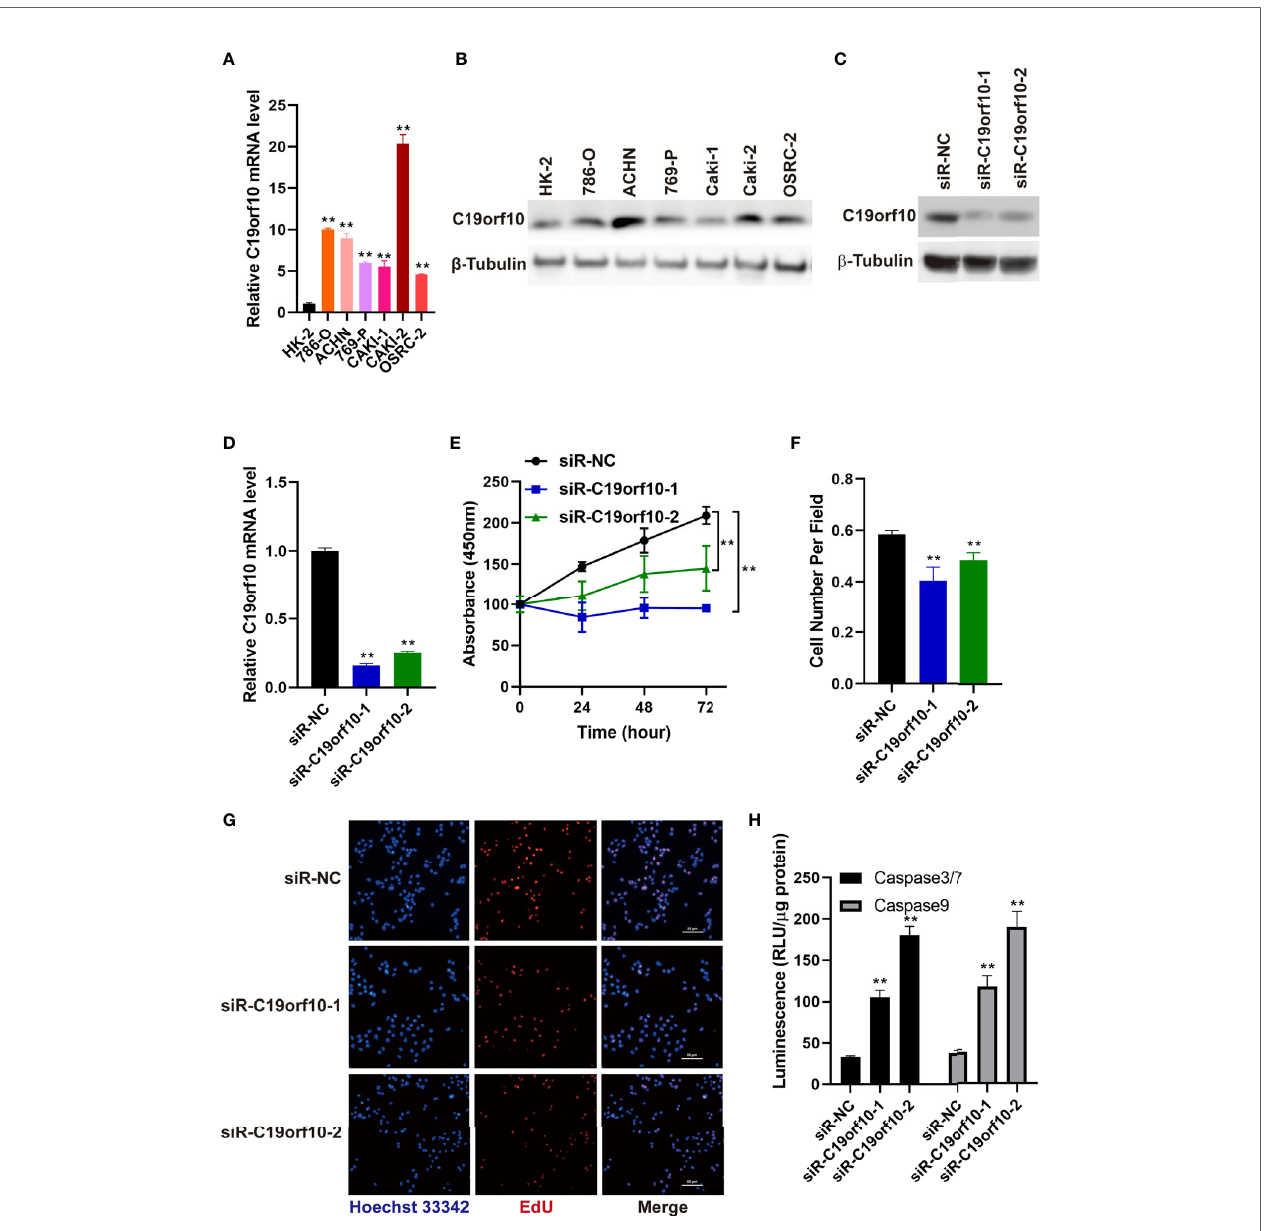
FIGURE 3 | Silencing C19orf10 reduced KIRC cell viability and proliferation in vitro . (A) C19orf10 mRNA expression in KIRC cell lines and human renal proximal tubular cells (HK-2), n=3. (B) C19orf10 protein expression level in KIRC cell lines and human renal proximal tubular cells. (C, D) The silencing ef fi ciency of siRNAs targeting C19orf10 on protein (C) and mRNA level (D) , n=3. (E) Suppression of C19orf10 inhibited the KIRC cell viability in CCK-8 assay, n=3. (F, G) Knockdown of C19orf10 suppressed KIRC cell proliferation in EdU incorporation assay, n=8. (H) Knockdown of C19orf10 induced more cell apoptosis in ACHN cells, n=3. Scale bar, 50 m m. Mean ± SD is shown. ** P < 0.01 by Student ’ s t-test and two-way